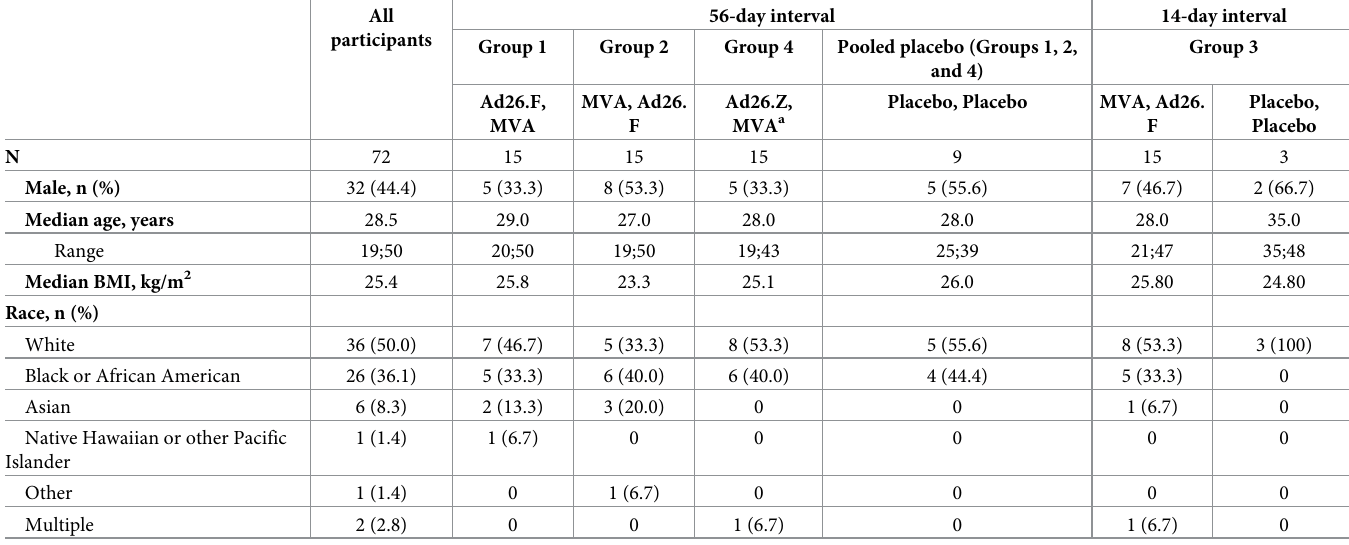
Table 1. Participant demographics and characteristics; full analysis set.